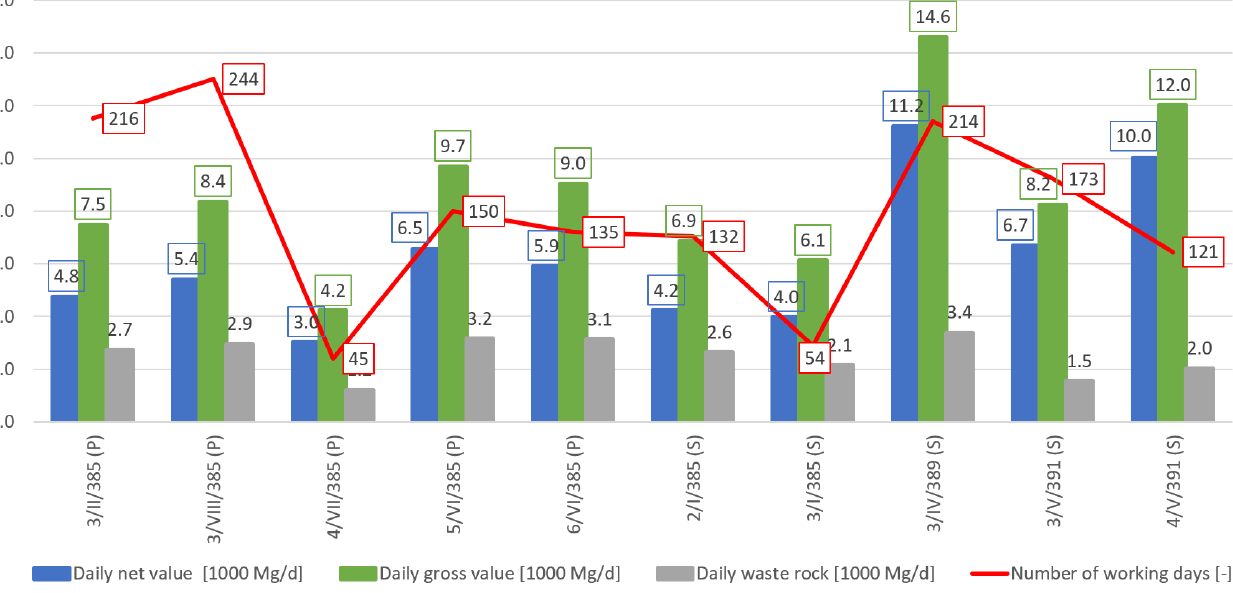
Figure 2. Summary of the daily output and total working time for longwalls in the analysed period of time.